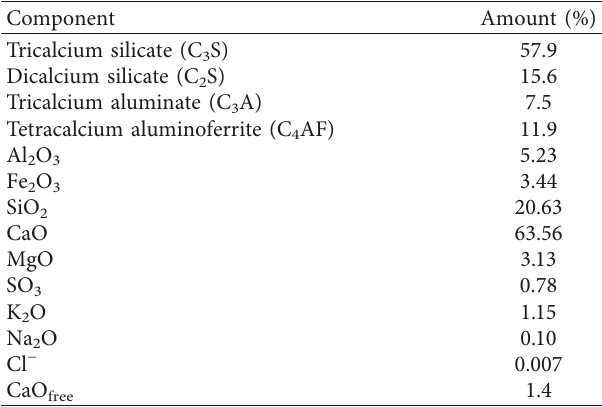
Table 1: Mineral and chemical composition of cement.